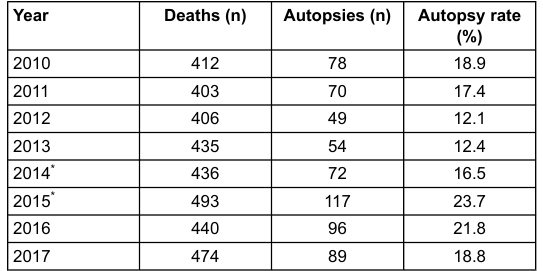
Table 8: Autopsy rates from 2010 to